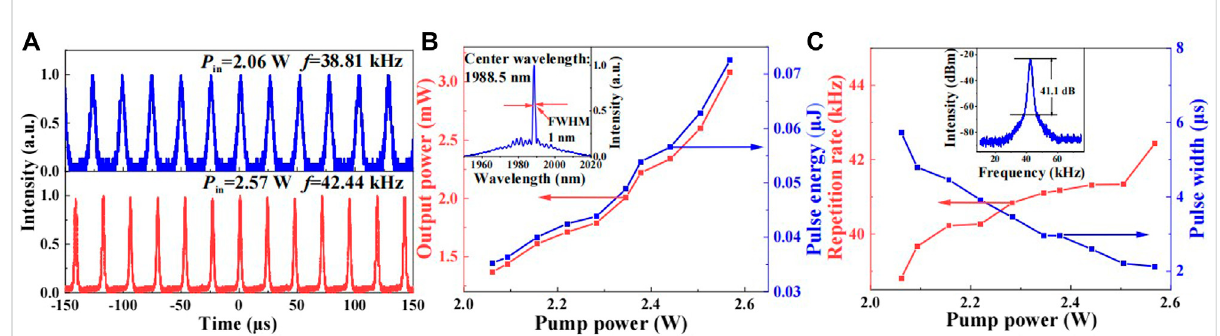
FIGURE 6 (A) Q-switched pulse trains at the launched pump power of 2.06 W and 2.57 W; (B) Output power and single-pulse energy as functions of the pumppower, inset:opticalspectraoftheQ-switchedpulses; (C) repetitionrateandpulsewidthasfunctions ofthepumppower,inset: RFspectraof the Q-switched pulses.